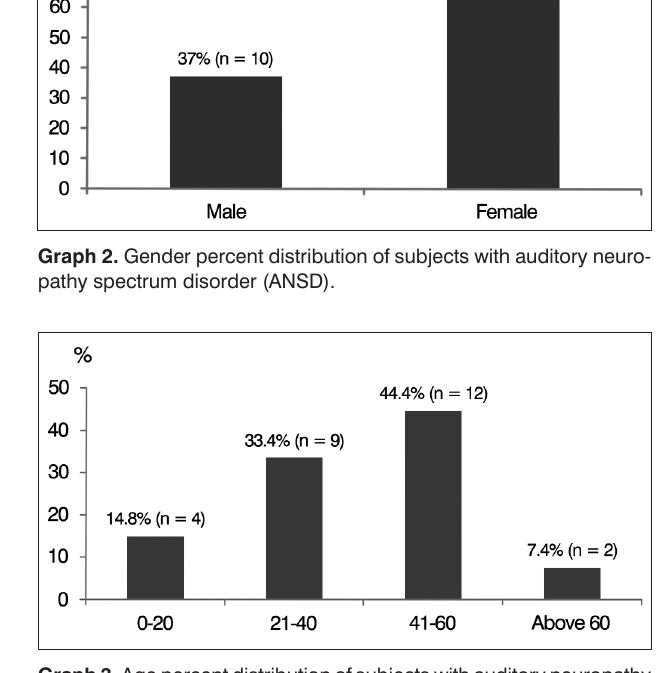
Graph 3. Age percent distribution of subjects with auditory neuropathy spectrum disorder (ANSD).